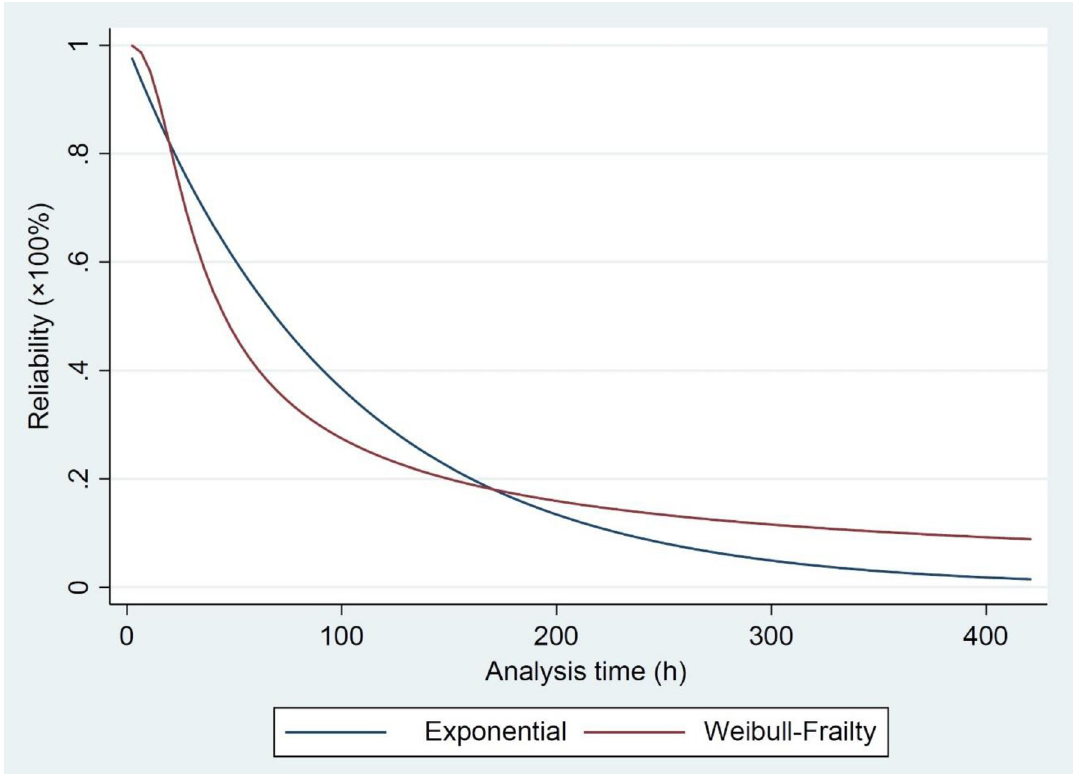
Fig 4. The reliability analysis in the classic-exponential model compared to the Weibull-frailty-model.